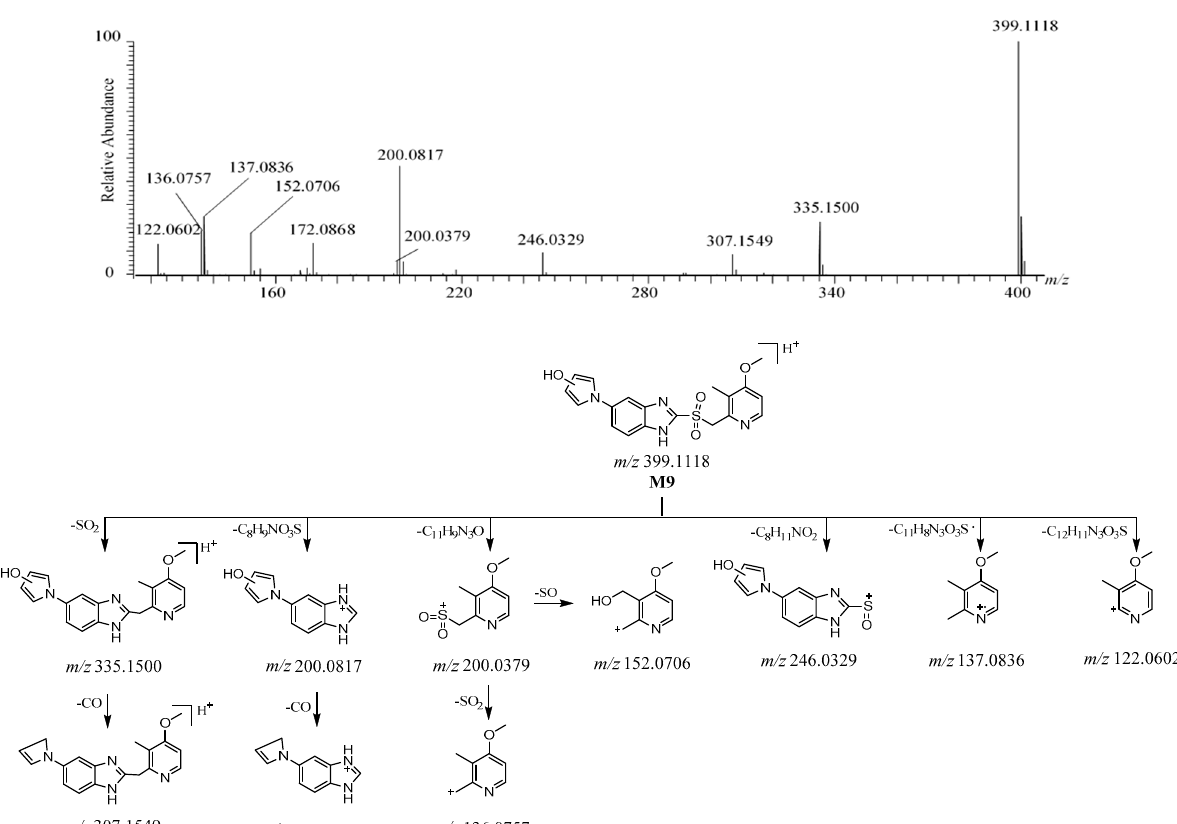
Figure 9. The HRMS/MS spectrum and the possible fragmentation pathway of M9.